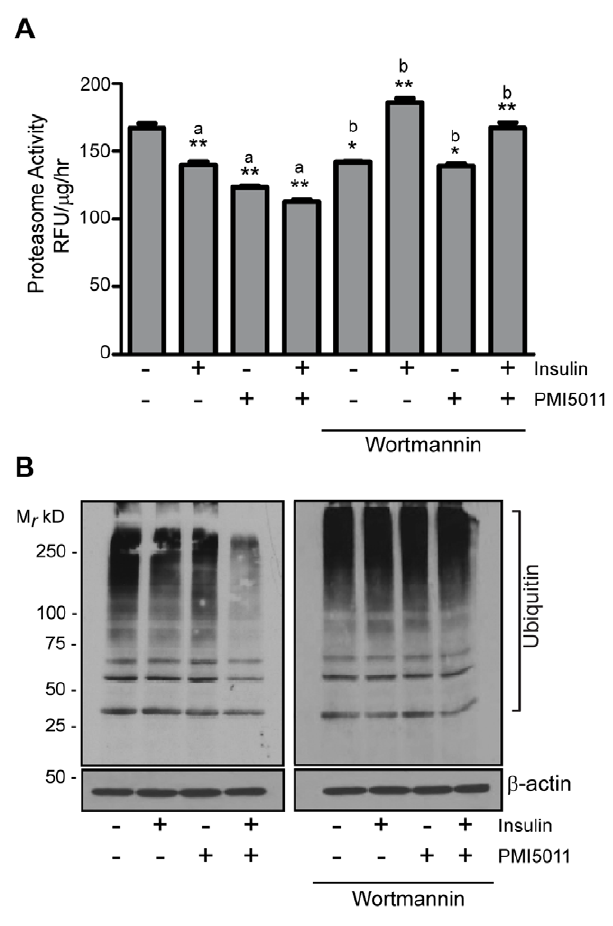
Figure 3. PMI5011 enhances the effect of insulin on protea- some activity and inhibits ubiquitylation in skeletal muscle. C2C12 myotubes were incubated with 10 m g/ml PMI5011 for 16 hours. The cells were subsequently incubated with wortmannin (200 nM) for 1 hour prior to the addition of insulin (100 nM) for 2 hours as indicated. (A) The cells were harvested and assayed for the chymotrysin-like protease activity of the proteasome. Proteasome activity is reported as Relative Fluorescence Units (RFU) RFU/ m g protein/hr. The data are reported as the mean 2 / + standard deviation from triplicate measurements and are representative of three independent experi- ments. a=compared to control; b=compared to related treatment ( 2 ) wortmannin; * p , 0.05, ** p , 0.01 (B) Whole cell extracts were also subjected to SDS-PAGE followed by western blot analysis using an anti- ubiquitin antibody to assay steady-state ubiquitylation levels. The data are representative of three independent experiments.